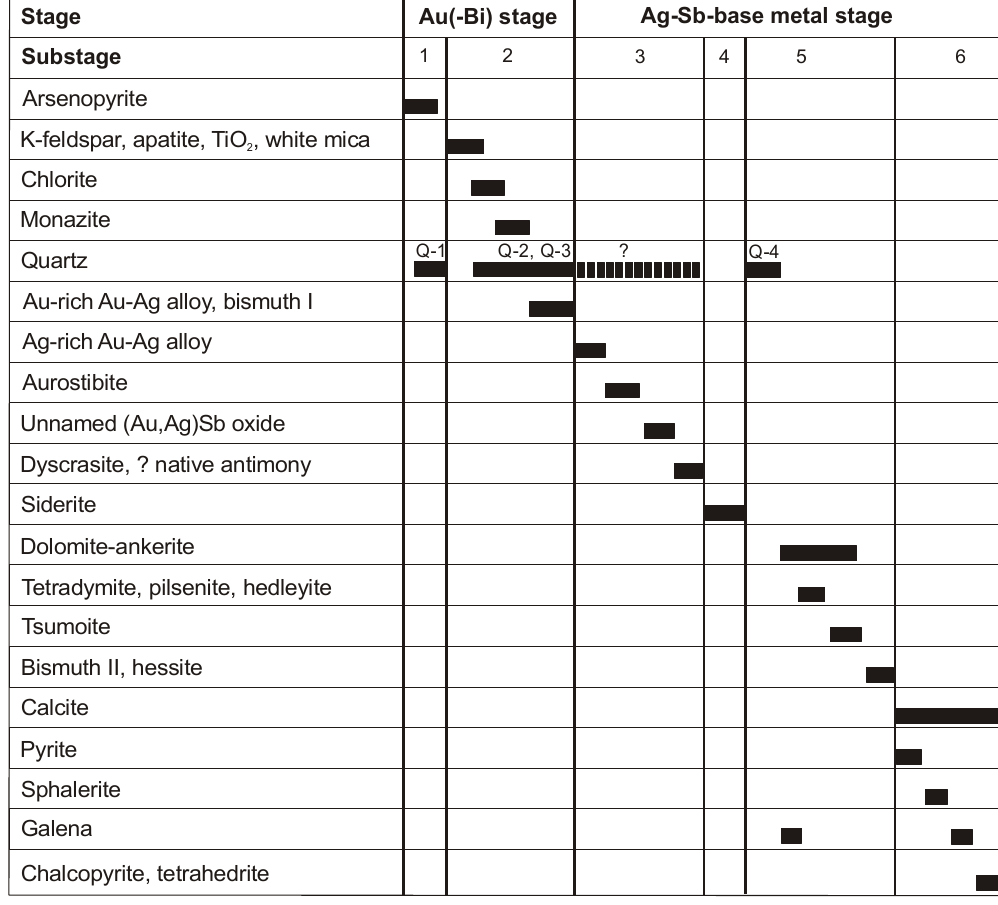
Figure 26. Generalized paragenetic sequence of the studied Au-bearing vein from Bytíz.